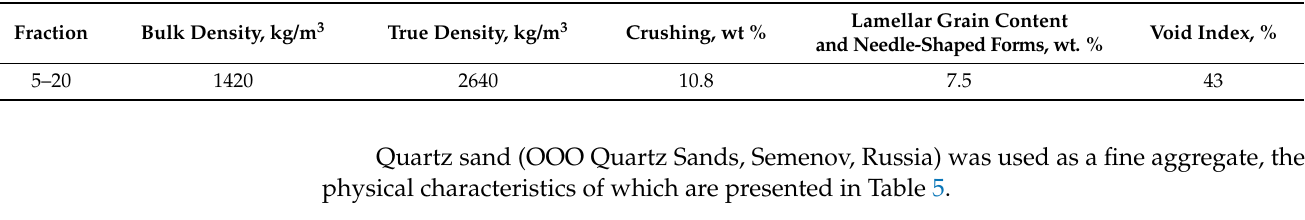
Table 5. Physical characteristics of dense fine